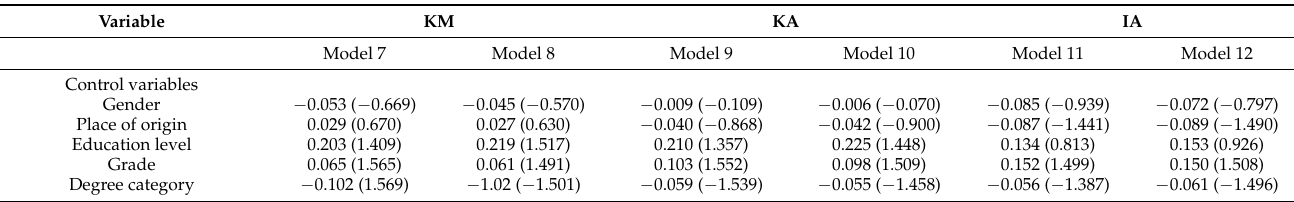
Table 4. Adjusting effect of connected classroom